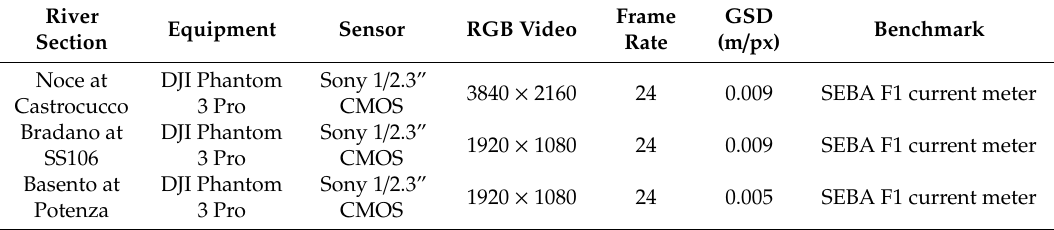
Table 2. Footage properties and reference velocity